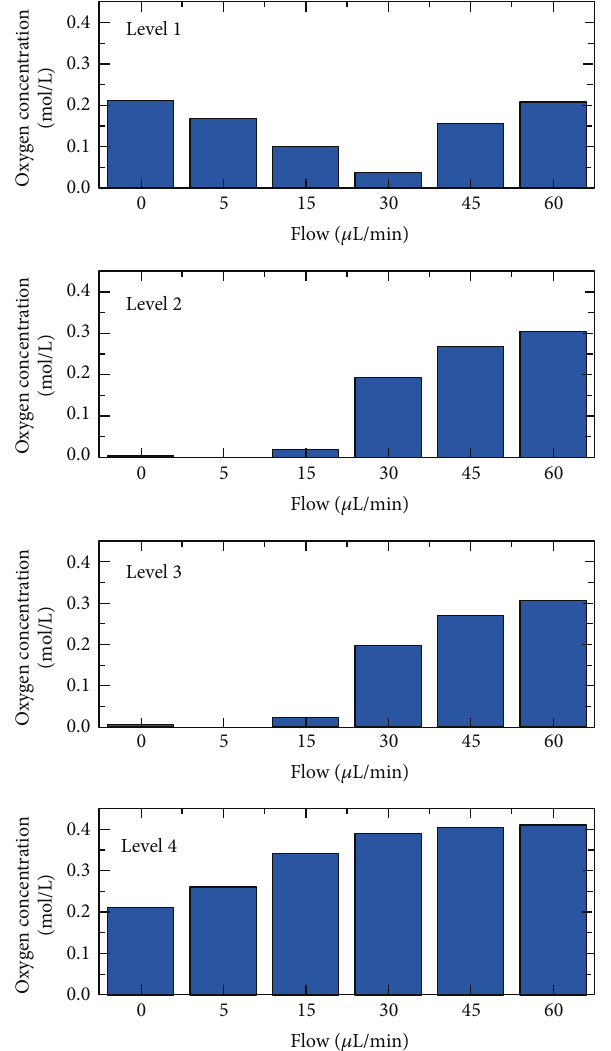
Figure 8: Oxygen concentration for the analysis levels 1–4 at different nutrient supply rates.